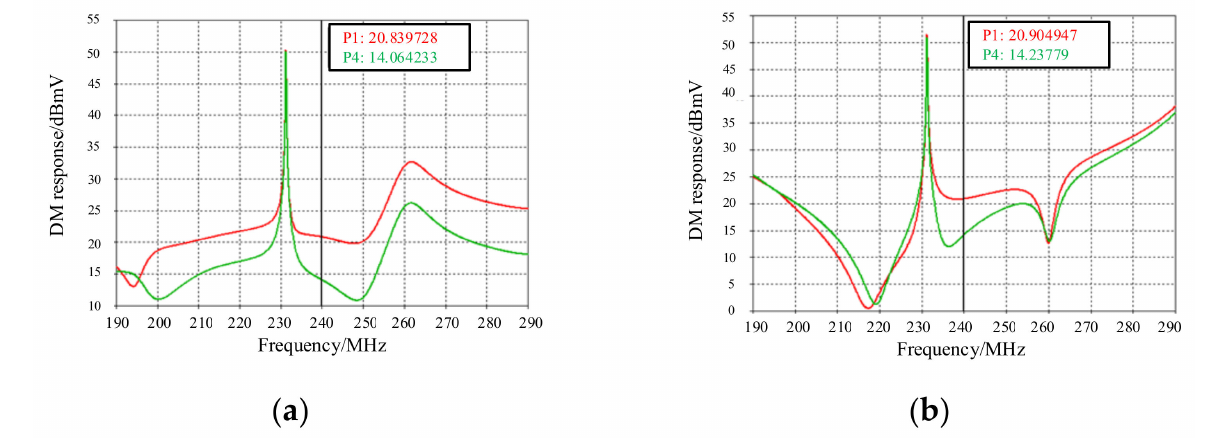
Figure 8. Extrapolation simulation (left end impedance is 16.7 Ω , right end impedance is 37.5 Ω : ( a ) radiation; ( b ) injection.